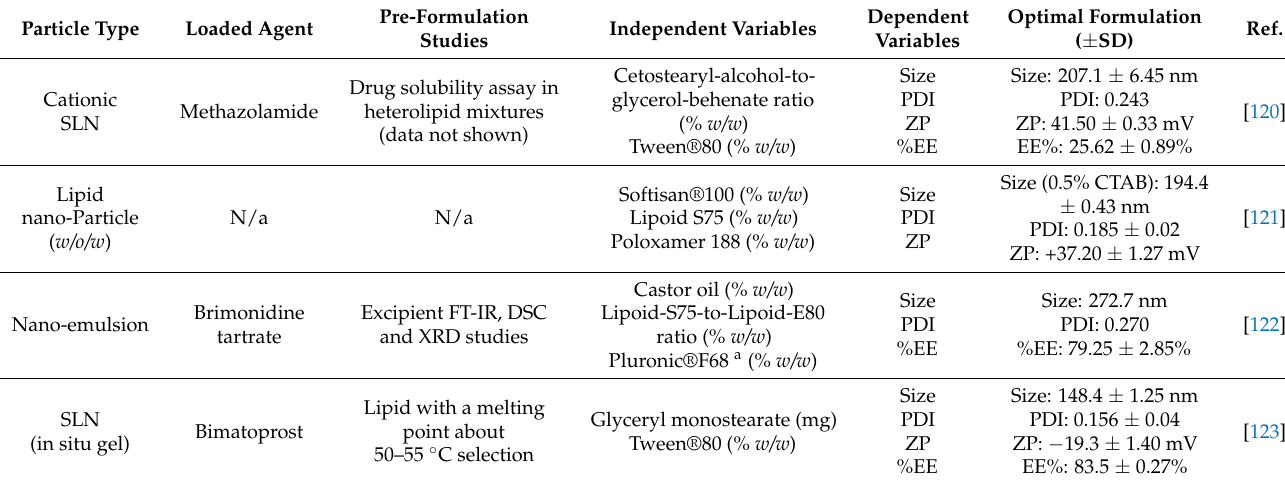
a Pluronic ® F68 = Poloxamer 188. Abbreviations: CTAB, cetyltrimethylammonium bromide; DSC, differential scanning calorimetry; FT-IR, Fourier-transform infrared spectroscopy; N/a, data not available/shown; PDI, polydispersity index; XRD, X-ray diffractometry; ZP, zeta potential; % w/w , weight concentration; %EE, drug entrapment efficiency expressed as a